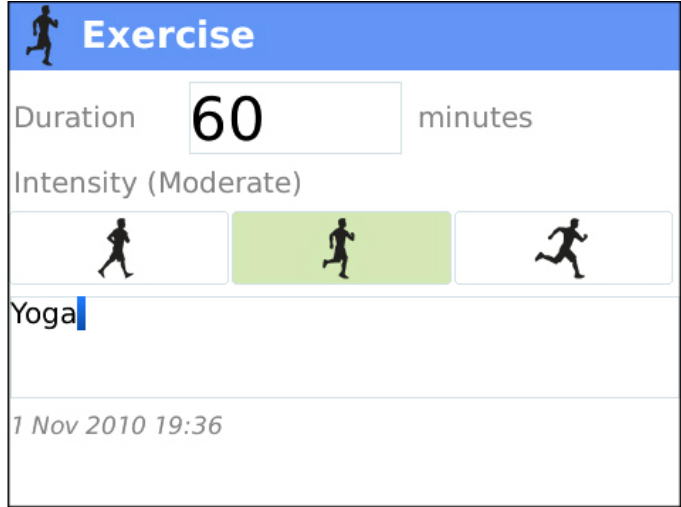
Figure 2. Exercise Tracker is designed to easily track multiple exercise modalities. Users can log duration of exercise, rate perceived intensity (light, moderate, vigorous), and enter additional text